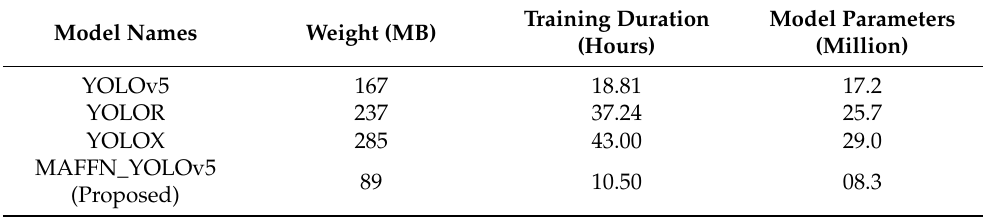
Table 2. Performance comparison of training results of the object detection